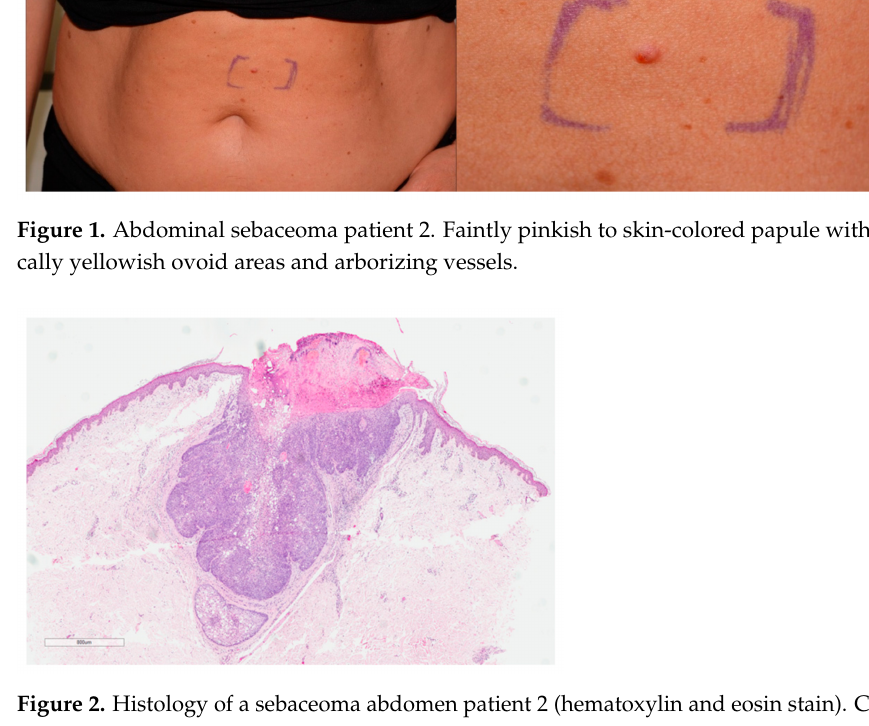
Figure 2. Histology of a sebaceoma abdomen patient 2 (hematoxylin and eosin stain). Circumscribed basaloid tumor with sebaceous differentiation and